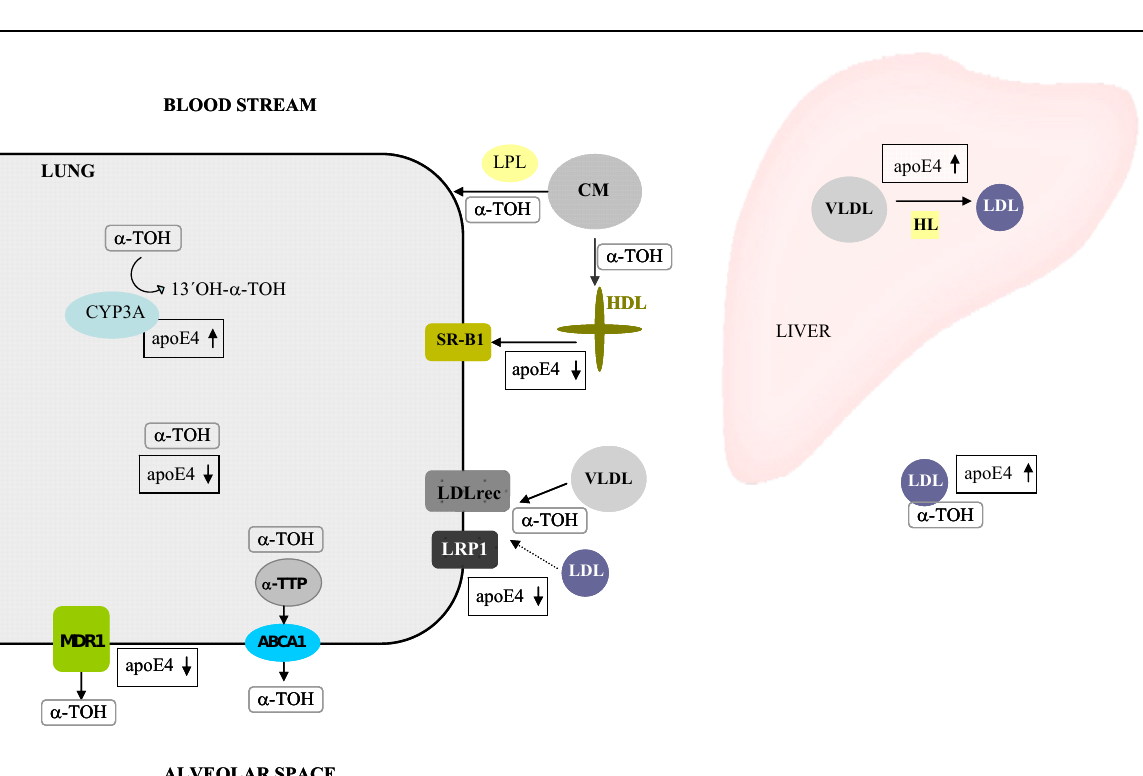
Figure 6. Proteins involved in the metabolism of α -tocopherol ( α -TOH) in the lung. α - tocopherol is distributed in the body via different lipoproteins and chylomicrons (CM). Cellular uptake of α -TOH is mediated by apoE and lipoprotein lipase (LPL) activity and their binding to several lipoprotein receptors including peripheral tissues (e.g., lung)receptor (LDLrec) and LDL receptor related protein 1(LRP1). Intracellular α -TOH is subjected to mitochondrial degradation by the cytochrome P450 family 3A (CYP3A) enzyme subfamily. Delivery of α -TOH to the alveolar space is facilitated by the activity of the α -tocopherol transfer protein ( α -TTP) and ATP-binding cassette A1 (ABCA1). Excessive amounts of α -TOH may be also excluded via the multidrug resistance transporter 1 (MDR1) (according to